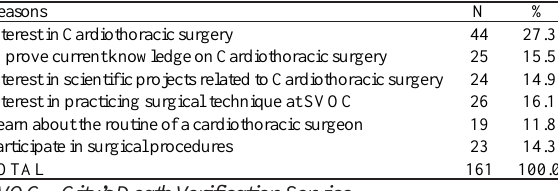
Table 1. Reasons given for interest in joining